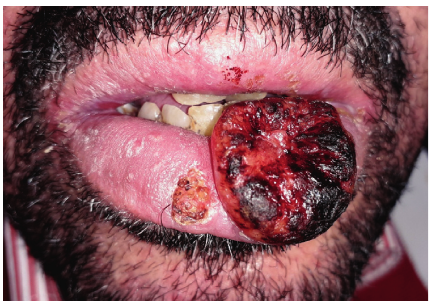
Figure 1: Preoperative view: small lesion with regular round border on the middle lower lip and a large, budding, crusty, and hemorrhagic lesion on the left side of the lower